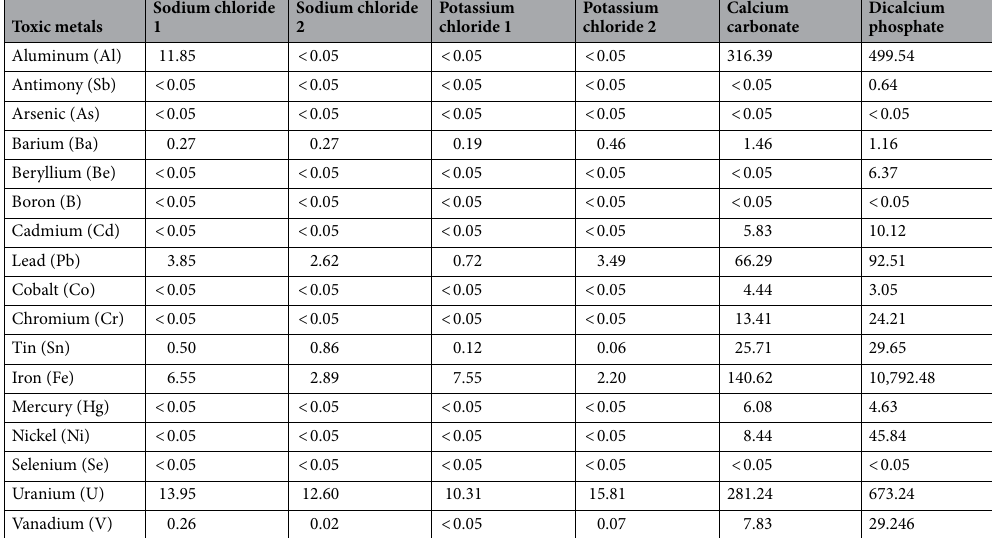
Table 14. Toxic metals concentrations (mg/kg) of in the analyzed mineral supplements. SEM standard error mean, P probability of significance. a,b Means followed by different letters in the lines differed (P <